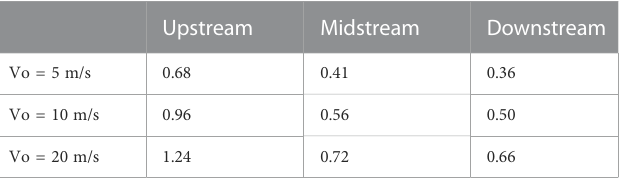
TABLE 2 Average speed from upstream to downstream calculated by SST model. Unit: m/s. Upstream Midstream